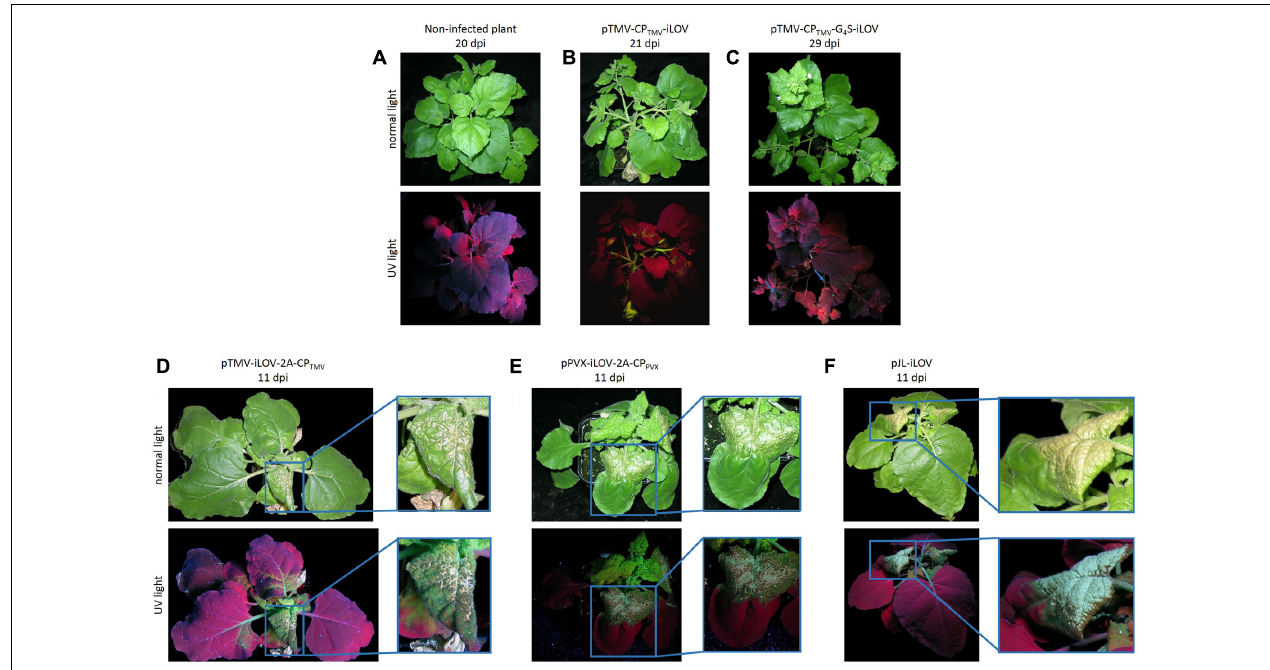
FIGURE 2 | Symptoms of infection and detection of fluorescence produced in N. benthamiana plants inoculated with TMV- and PVX-derived vectors for the expression of iLOV. (A) Non-infected N. benthamiana plant and plants infected with (B) pTMV-CP TMV -iLOV, (C) pTMV-CP TMV -G 4 S-iLOV, (D) pTMV-iLOV-2A-CP TMV , (E) pPVX-iLOV-2A-CP PVX , and (F) pJL-iLOV were viewed under UV light or normal light 11–29 dpi depending on the infection progress. All plants showed evidence of systemic infection as revealed by the green fluorescence. Plants infected with pPVX-iLOV-2A-CP PVX , pTMV-iLOV-2A-CP TMV , or pJL-iLOV showed the most severe symptoms, including necrotic